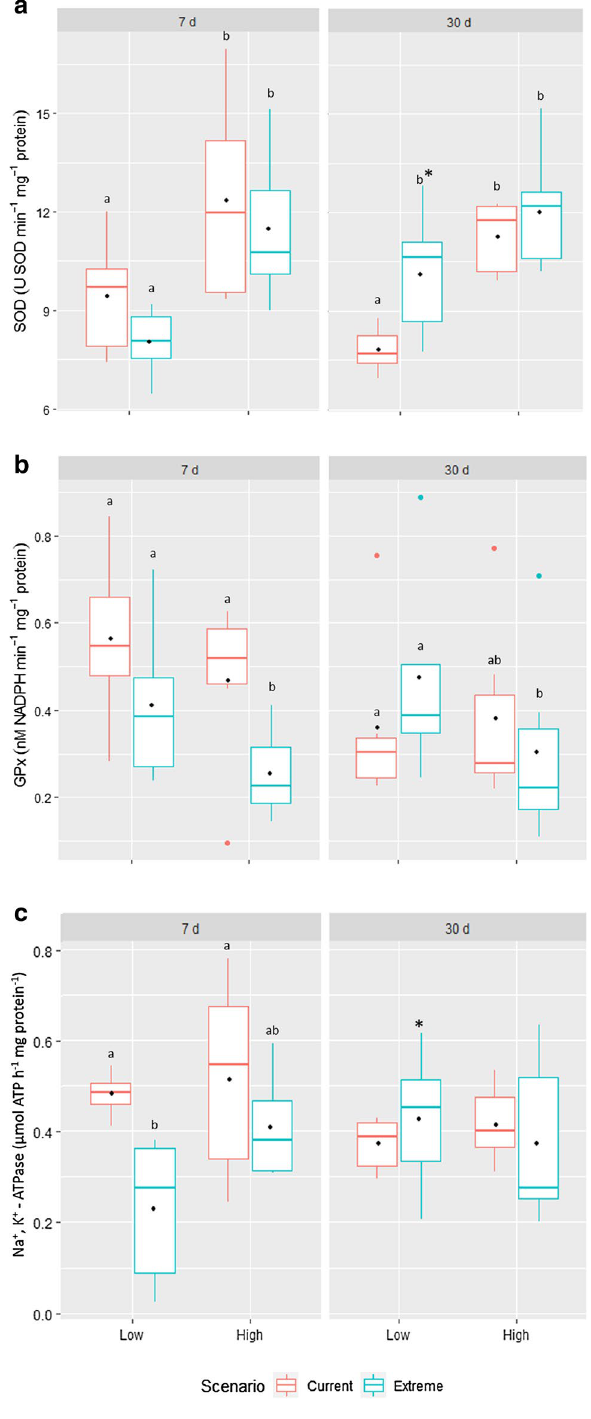
Figure 2. Enzymatic activity of SOD ( a ), GPx ( b ) and NKA ( c ). Low (LG) and High (HG) indicate parasitism level. Boxes with different letters indicate differences between scenarios and asterisks indicate differences between exposure periods ( p < 0.05). A black dot in the box indicates the average of each